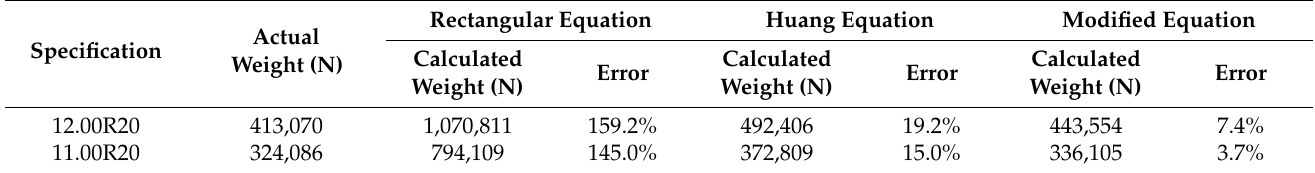
Table 8. Gross weight identification results for trucks.